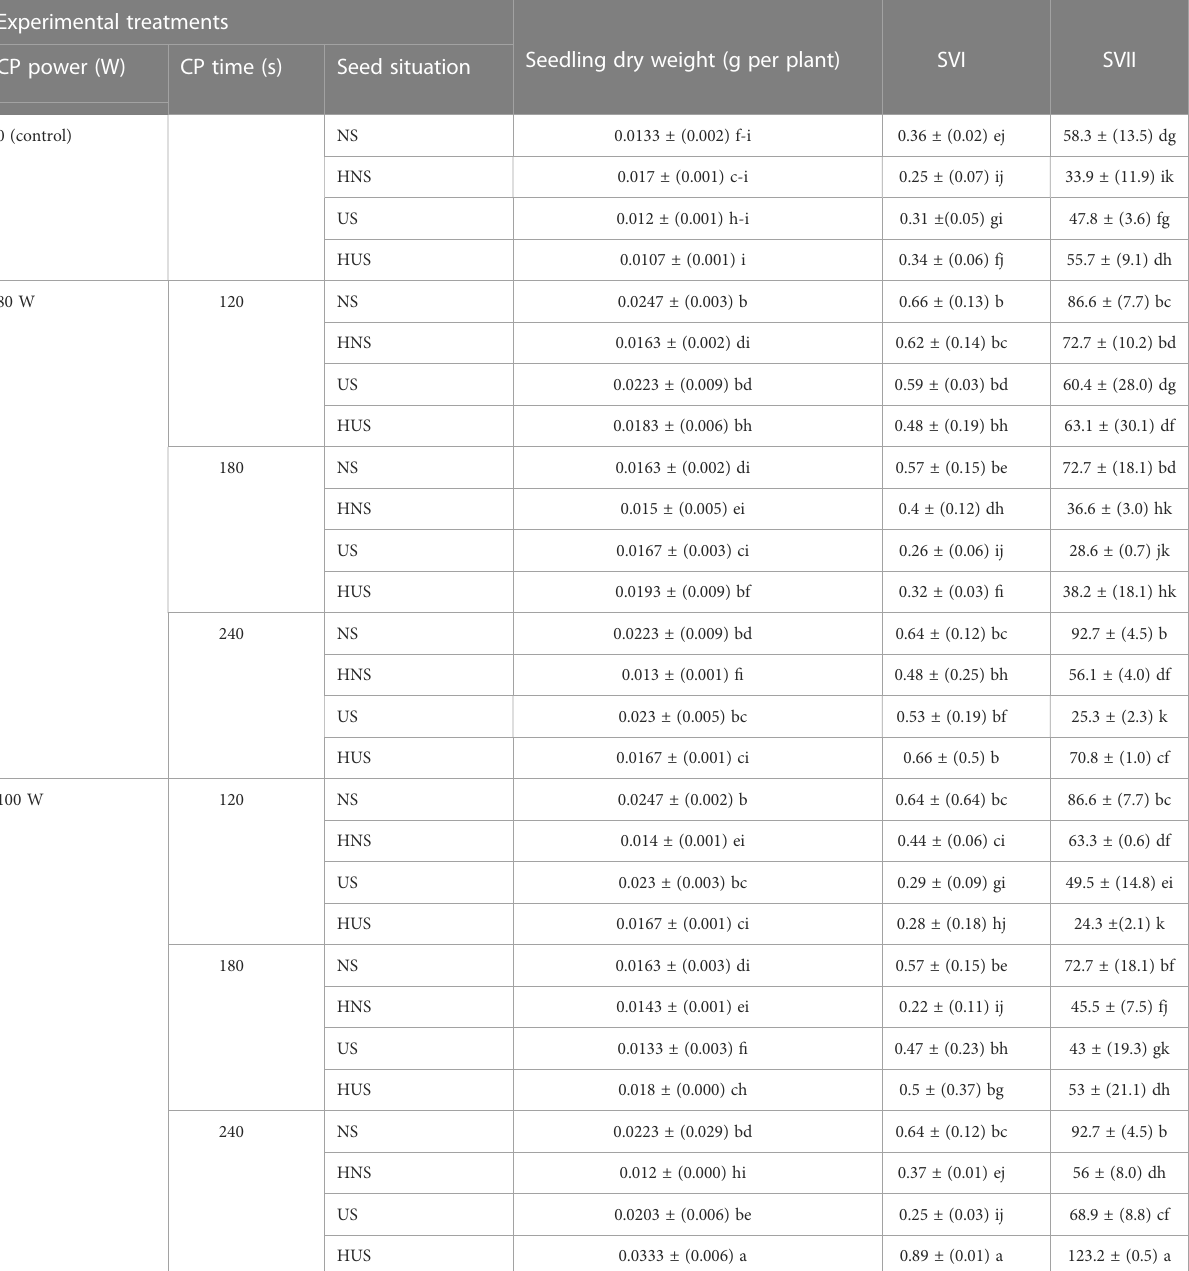
Valuesrepresentmean±S.E.Differentlettersindicatesigni fi cantdifferencesatthe5%levelaccordingtotheLSDtest.CP,coldplasma;NS,normalseeds;US,uncoveredseeds;HNS,hydro- primed normal seeds; HUS, hydro-primed uncovered seeds; LSD, least signi fi cant